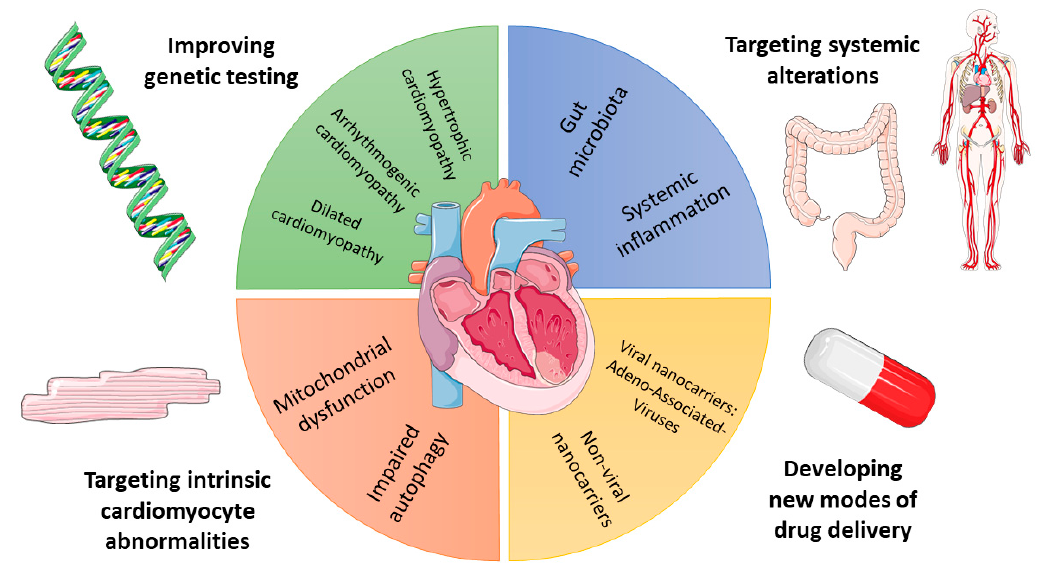
Figure 1. Areas of basic science research into heart failure covered by this review.